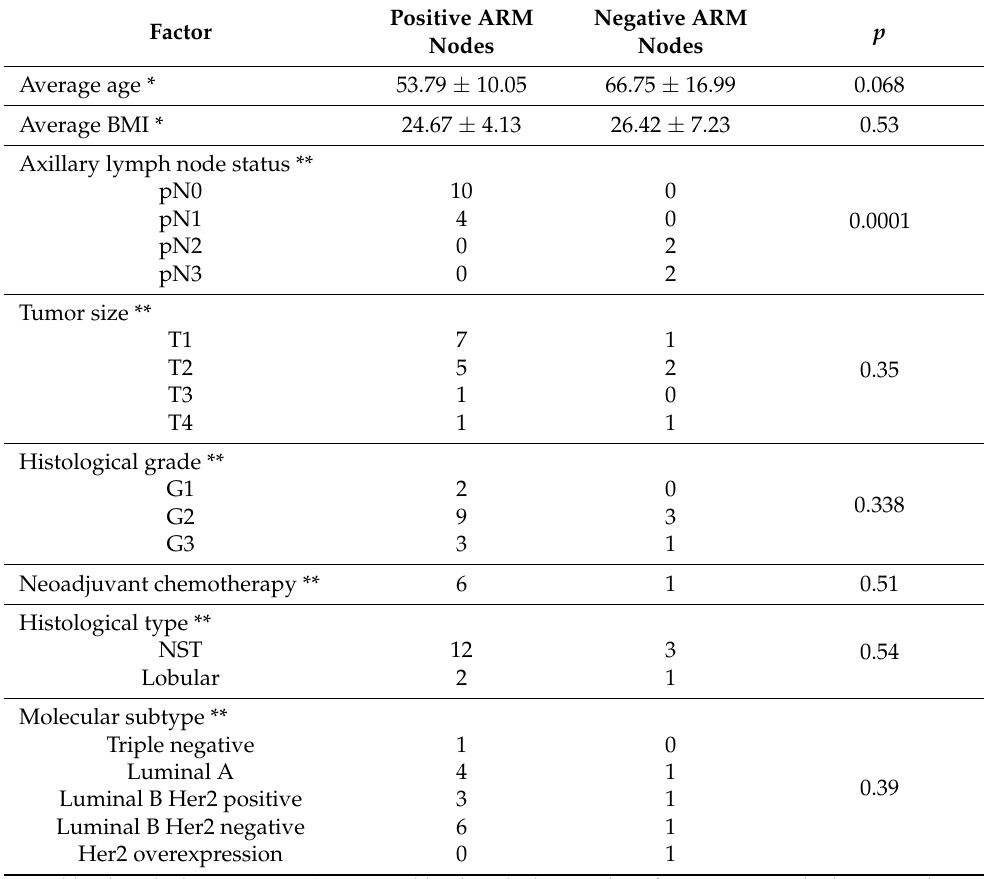
Table 2. Factors that might influence metastatic involvement of ARM